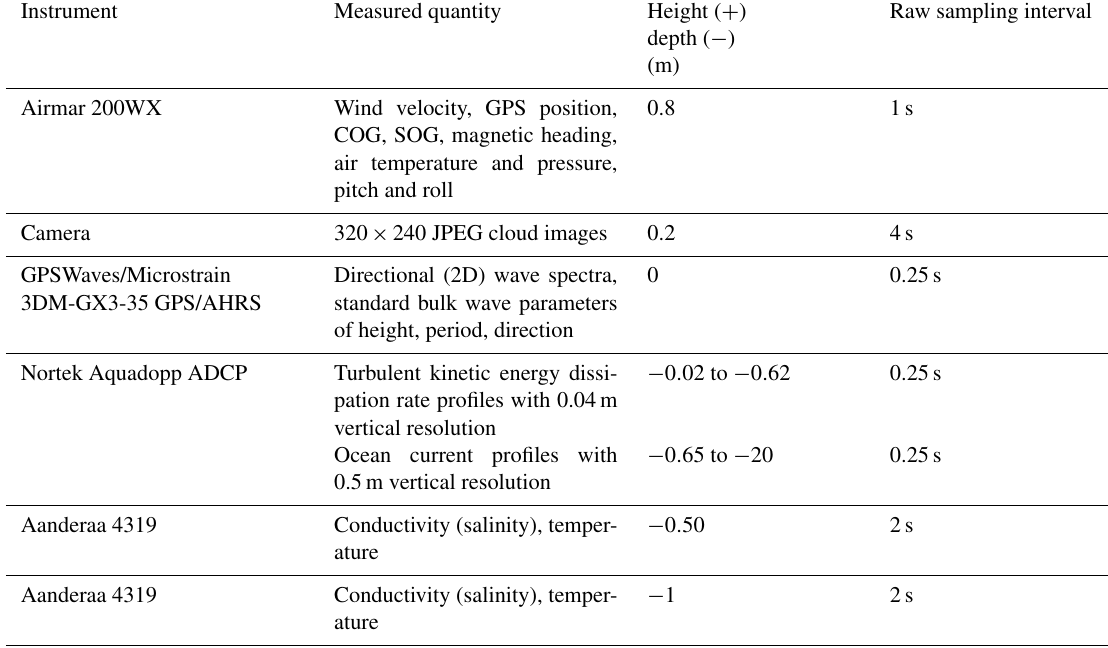
Table 9. Instrumentation on board the v3 SWIFTs (serial numbers 16 and 17) for the measurement of atmospheric and seawater parameters. Measurements were collected during 8min bursts at the beginning of each hour. Final data products are 8min averages of high-resolution raw data and time-stamped at the beginning of the